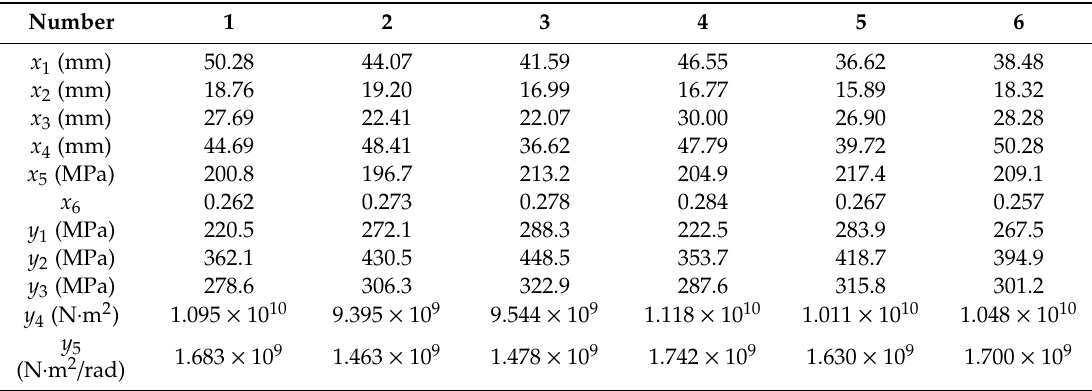
Table 8. Sample data and corresponding responses for constructing approximate